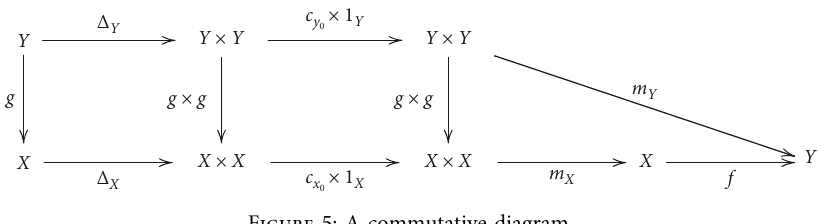
Figure 5: A commutative diagram.